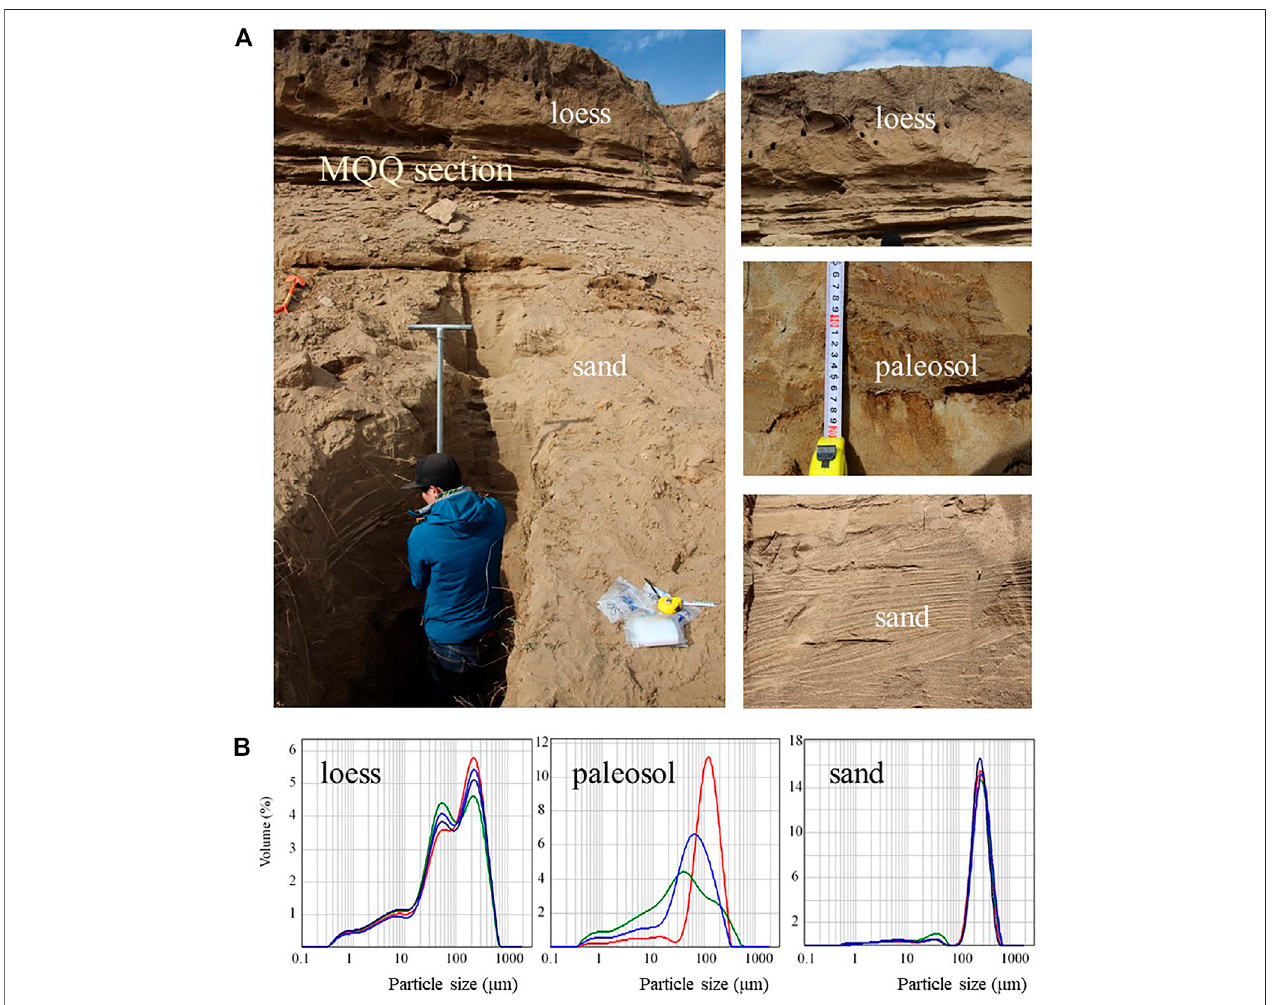
FIGURE 2 | (A) Photographs of the MQQ pro fi le. (B) Grain size distributions in representative samples of loess, paleosol, and aeolian sand from the MQQ pro fi le (different lines in color represent different samples).